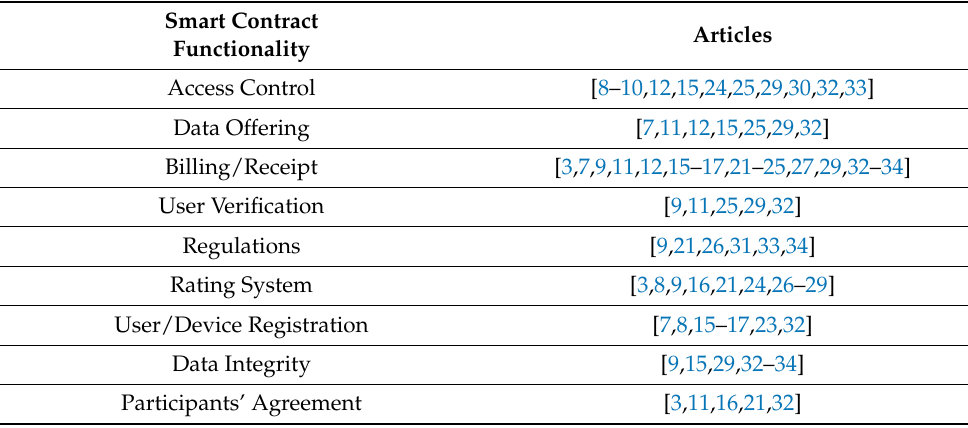
Table 2. Smart contract utilization in each